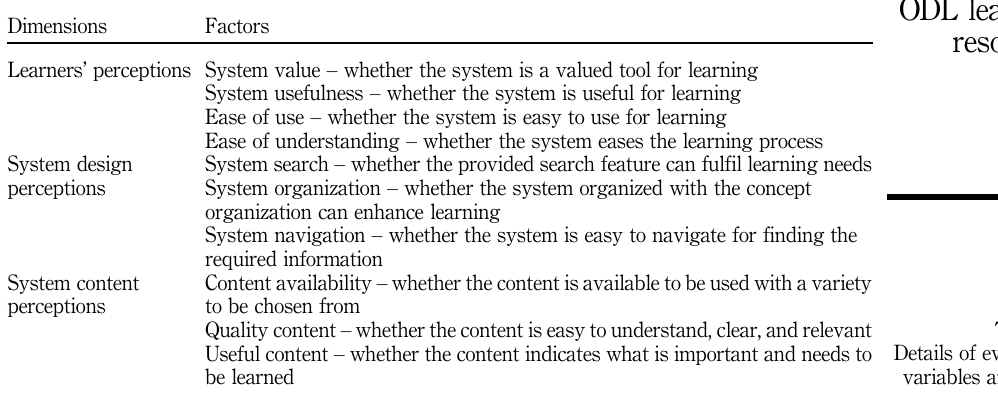
Table I. Details of evaluation variables and